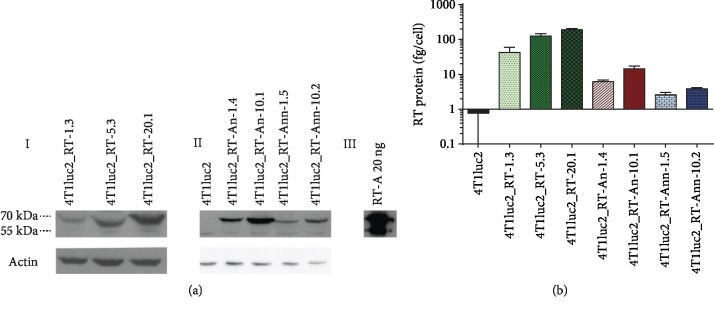
Expression of reverse transcriptase (RT) by 4T1luc2-derived cell lines carrying genomic inserts of sequences encoding variants of the consensus HIV-1 FSU_A RT. (a) Western blot analysis of lysates of derivative 4T1luc2 clones (Table 2) stained with rabbit polyclonal anti-RT antibodies [68] (I and II upper panels), and anti-actin monoclonal antibodies (I and II lower panels), recombinant RT_A as positive control (III). The parental 4T1luc2 cell line was used as a reference. Polyclonal anti-RT antibodies weakly bind to reverse transcriptase expressed by the lentivirus used to generate the parental 4T1luc2 cell line (II). Position of the weight mass marker is shown on the left. (b) Quantification of RT_A expression using ImageJ software. Signal in the lane corresponding to a given derivative clone was quantified using calibration curve built with the help of recombinant RT_A. Total amount of the expressed RT_A variant was divided by the number of cells used to make the lysate (see Materials and Methods for description). Data represent the results (mean ± SD) from three independent experiments.